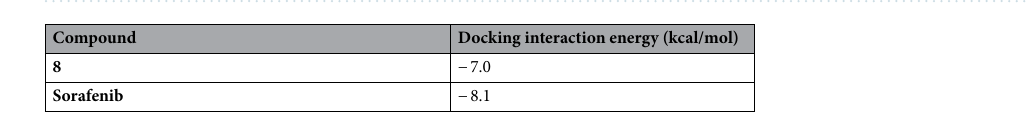
Table 6. Docking interaction energy of compound 8 against